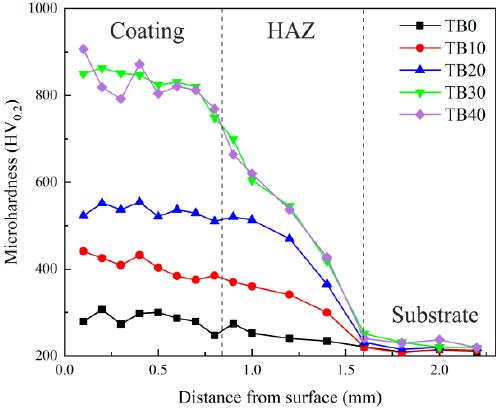
Figure 10. Microhardness distributions of coatings with different TiB 2 particles content.